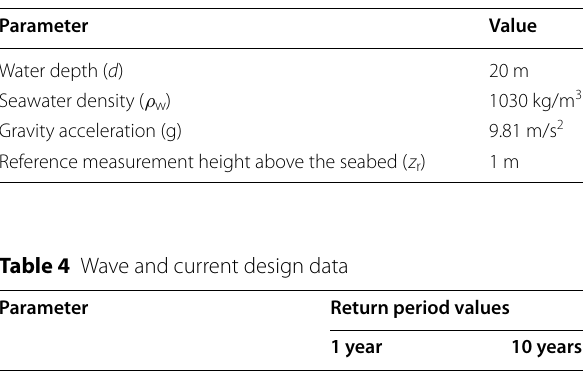
Table 3 Sea characteristics